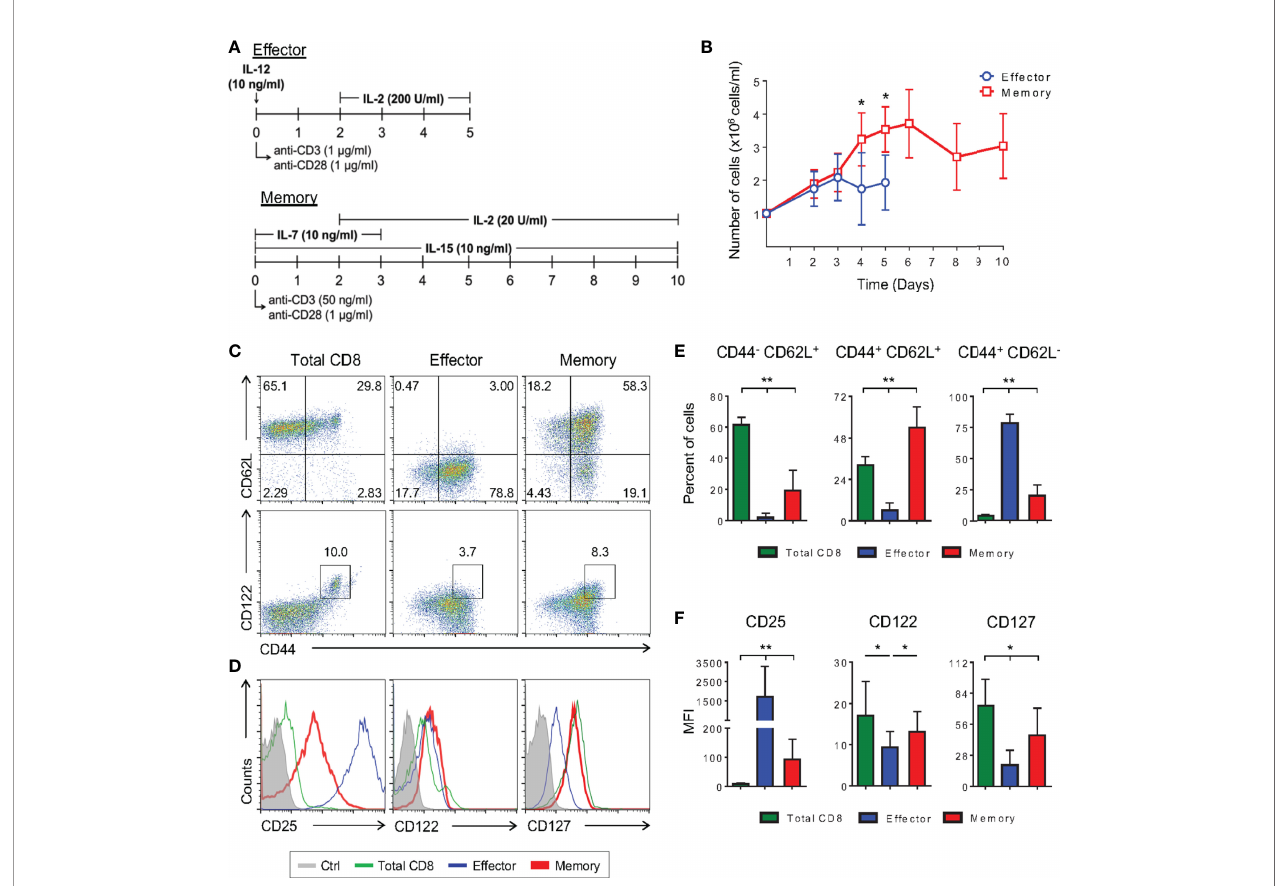
FIGURE 1 | Low TCR Avidity and a Low Dose of IL-2 Can Induce Long-Term Polyclonal Memory CD8 T Cells In Vitro . (A) Schematic representation of the differentiation regimen for the in vitro effector (top) and memory (bottom) CD8 T lymphocytes. (B) Number of effector and memory cells during differentiation culture quanti fi ed by trypan blue exclusion. (C, D) Negatively-selected puri fi ed (total) CD8 T cells and in vitro differentiated effector and memory CD8 T lymphocytes were labeled with anti-CD44, anti-CD62L, anti-CD122, anti-CD127 and anti-CD25 fl uorescently labeled monoclonal antibodies on the 5 th and 10 th days of culture, respectively. (E) Percentage of CD44 - CD62L + , CD44 + CD62L + and CD44 + CD62L - CD8 T cells. (F) Mean fl uorescence intensity (MFI) of anti-CD25, anti-CD122 and anti-CD127 fl uorescently labeled cells. All data are shown as the mean ± SD. The (*) indicates p < 0.05 and (**) p < 0.01 comparing all groups to each other. All results are representative of at least 13 independent experiments. Ctrl: unlabeled (gray); total CD8 (green); effector (blue); memory